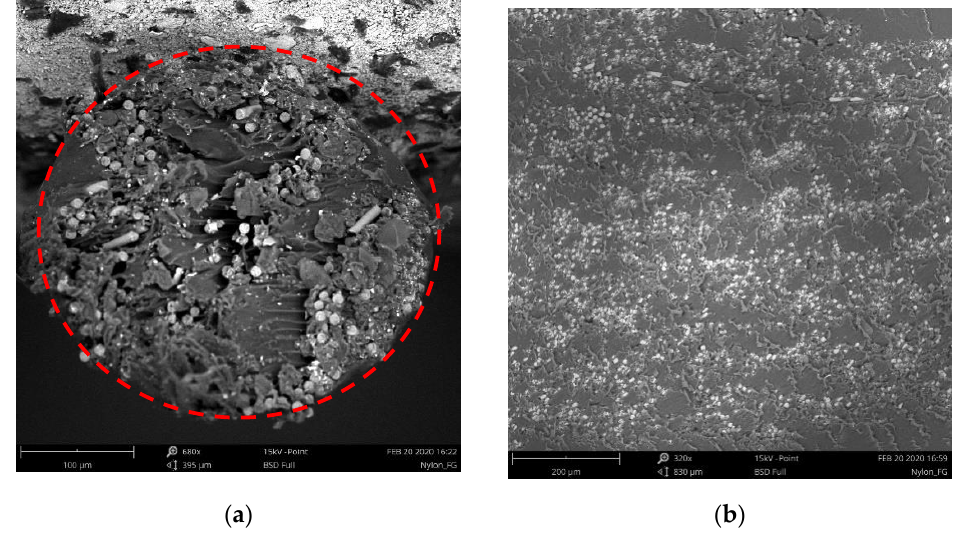
Figure 6. SEM microstructure of the cross section of nylon and nylon/fiberglass showing that ( a ) the glass filament (within the red dotted circle) contained empty space around fiber bundles and ( b ) the 3D printed specimen contained no extensive visible porosity.